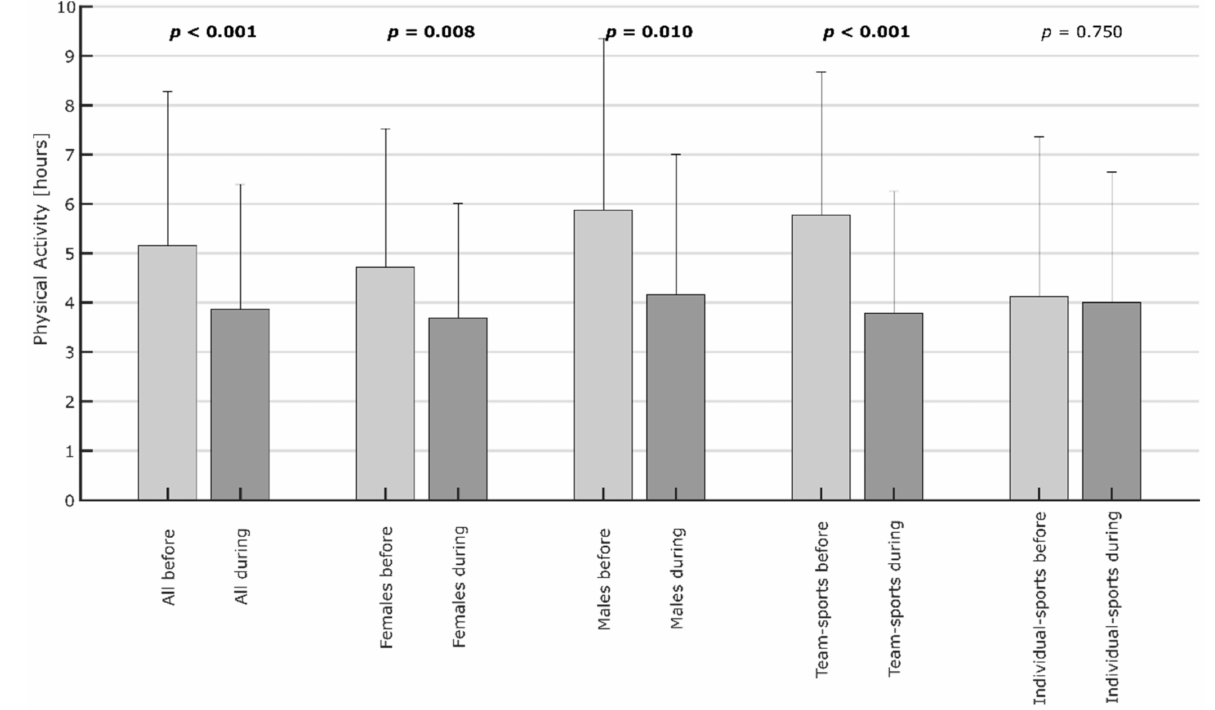
Figure 5. The impact of the pandemic on physical activity overall and clustered by gender and preference for individual sports versus team sports. Bold font indicates a statistically significant ( p < 0.05) difference in physical activity between before and during the SARS-CoV-19 pandemic.